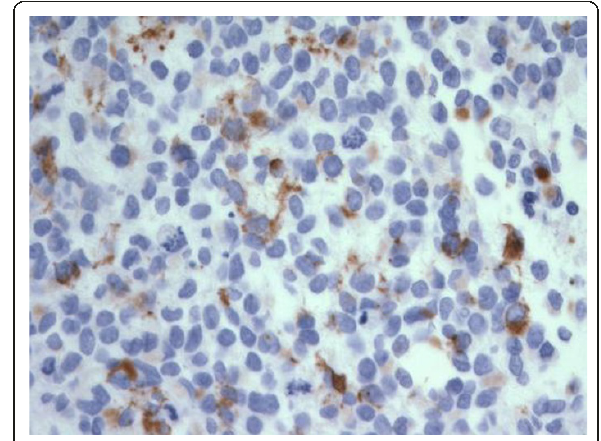
Figure 5 Microphotograph demonstrating cytoplasmic, punctate staining of malignant cells for Cam 5.2 . [400 ×.]